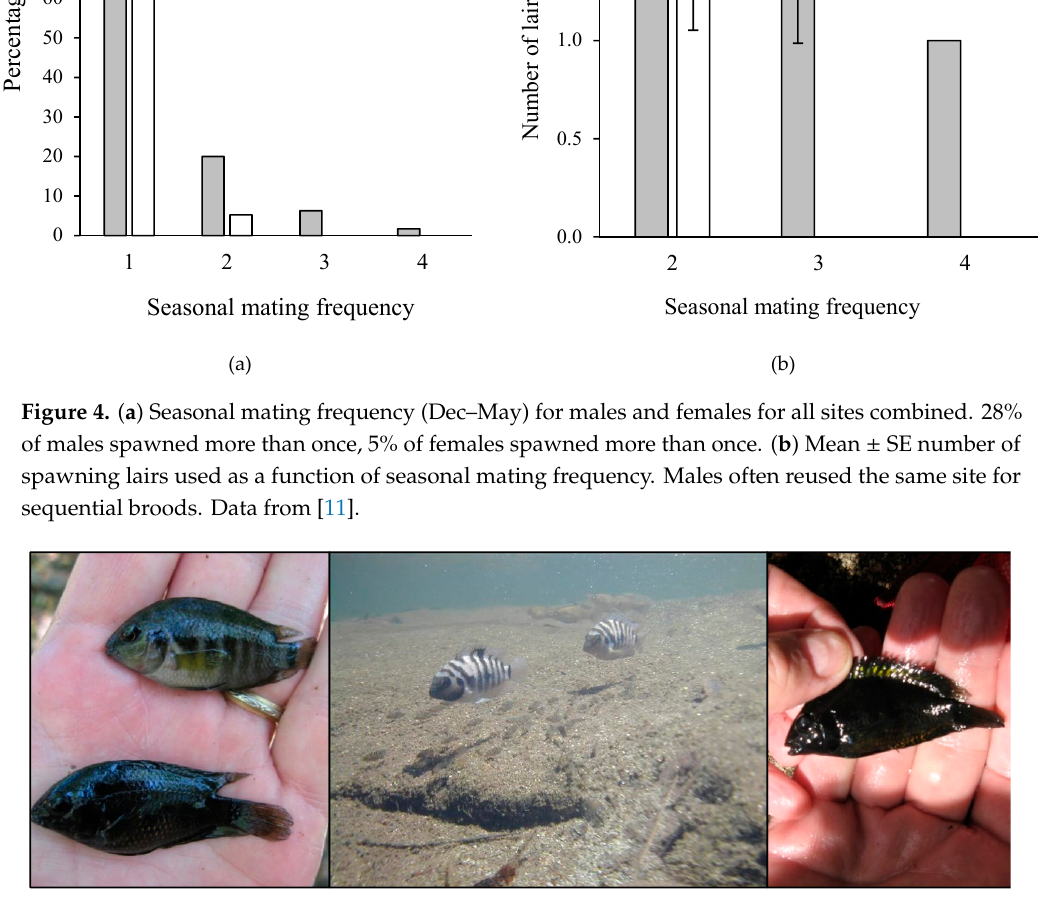
Figure 4. ( a ) Seasonal mating frequency (Dec–May) for males and females for all sites combined. 28% of males spawned more than once, 5% of females spawned more than once. ( b ) Mean ± SE number of spawning lairs used as a function of seasonal mating frequency. Males often reused the same site for sequential broods. Data from [11].